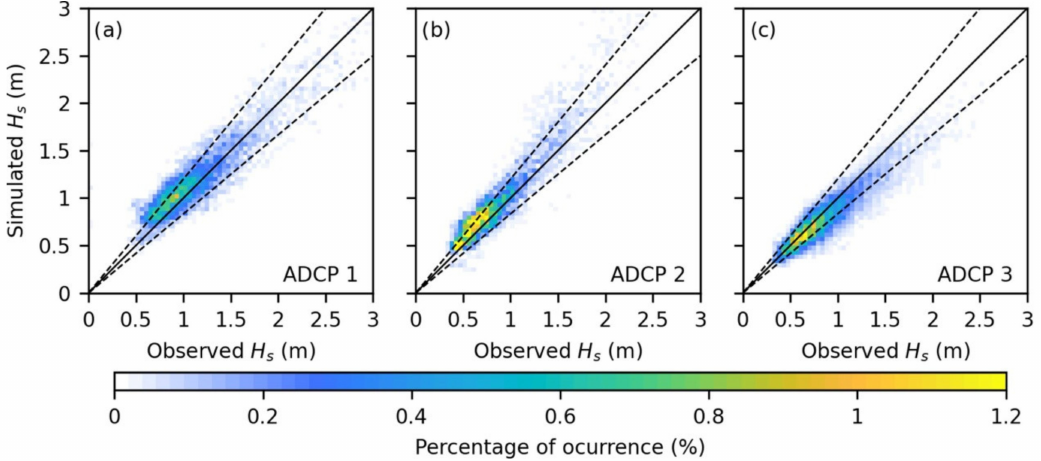
Figure 2. Comparison of the significant wave height ( H s ) simulated and observed at ADCP 1 ( a ), ADCP 2 ( b ), and ADCP 3 ( c ) measuring locations. Dashed lines are the 90% confidence limits based on sampling